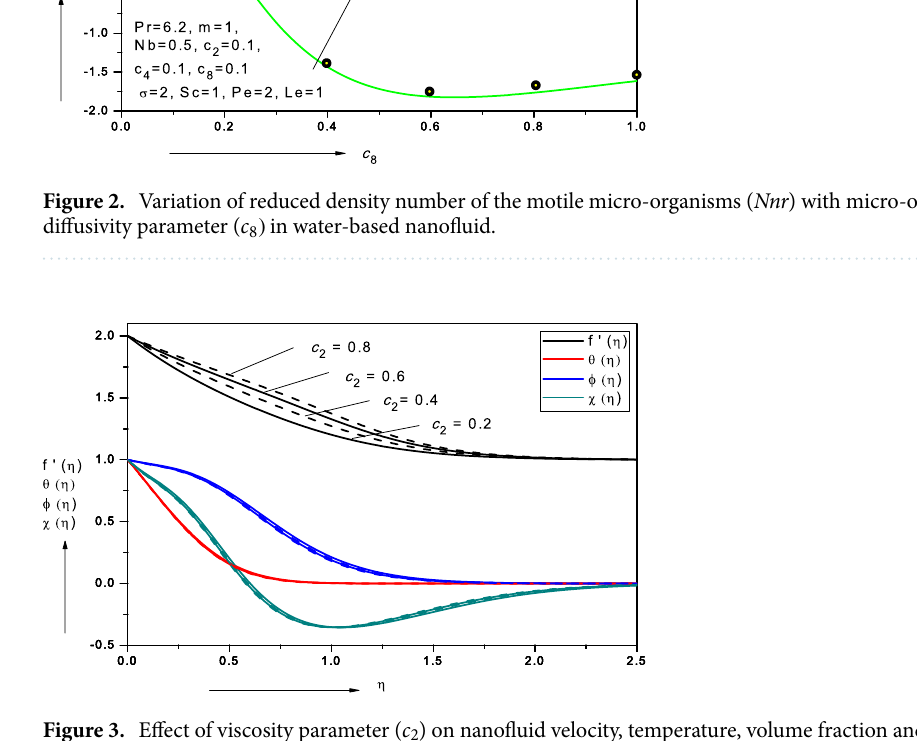
Figure 3. Effect of viscosity parameter ( c 2 ) on nanofluid velocity, temperature, volume fraction and motile micro-organism density number.